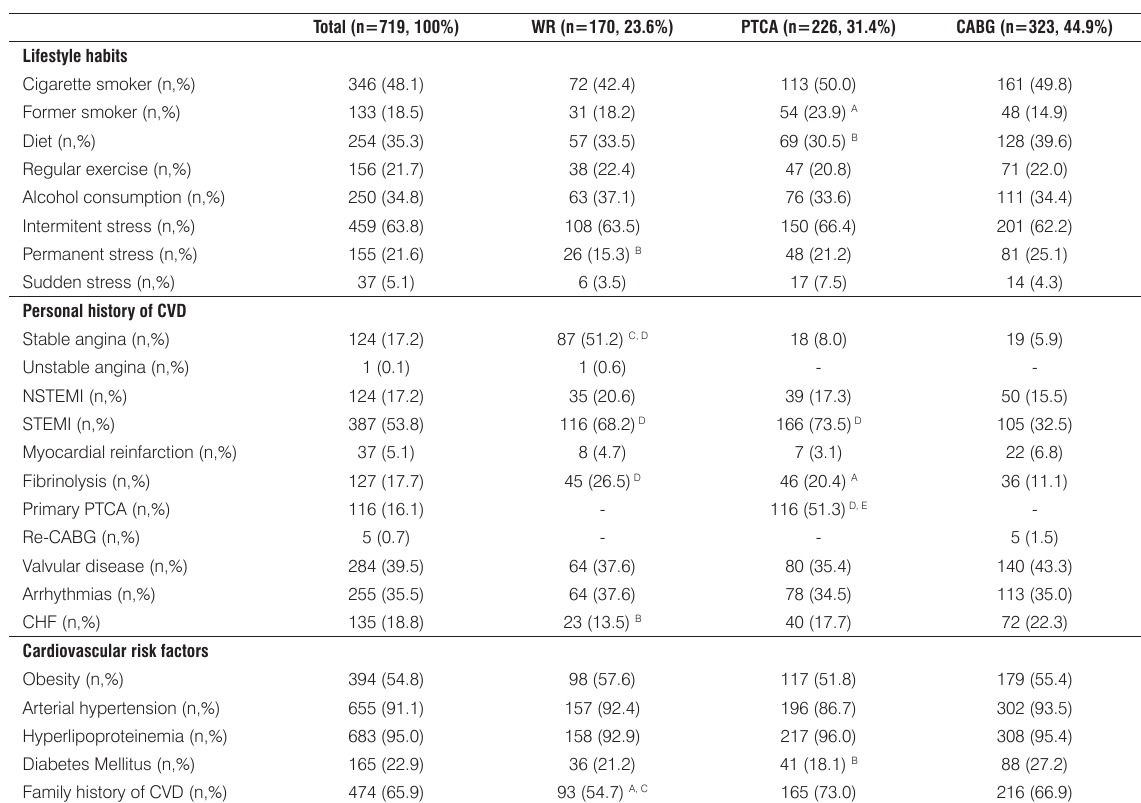
Table 2. Cardiovascular risk